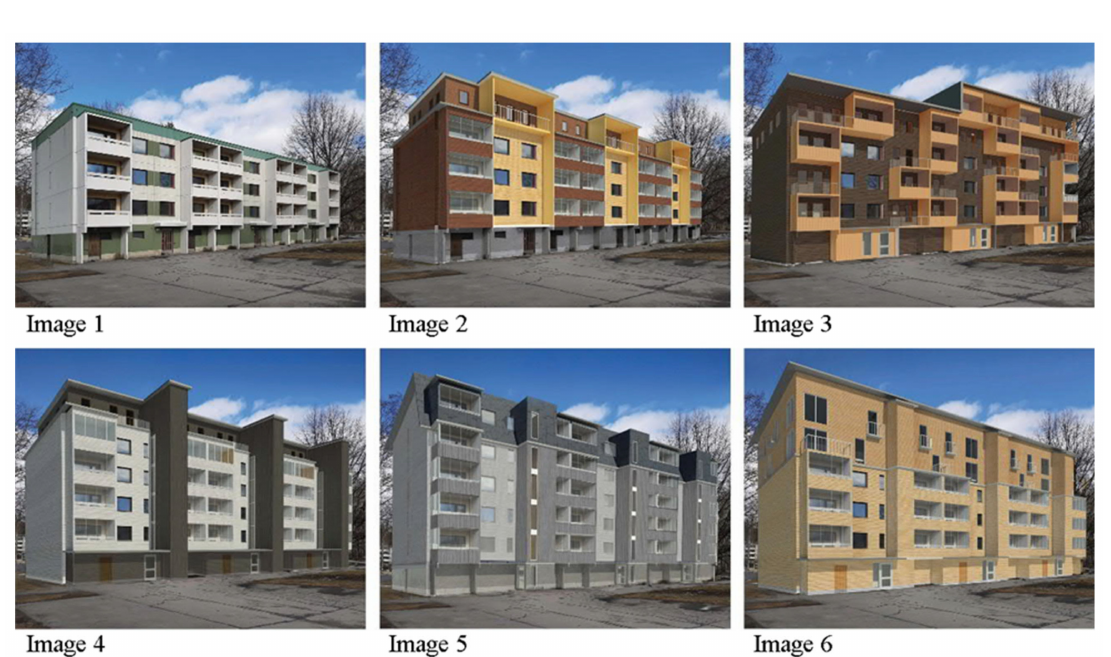
Figure 2. Original concrete apartment building ( Image 1 ) and proposed renovation alternatives ( Image 2 – 6